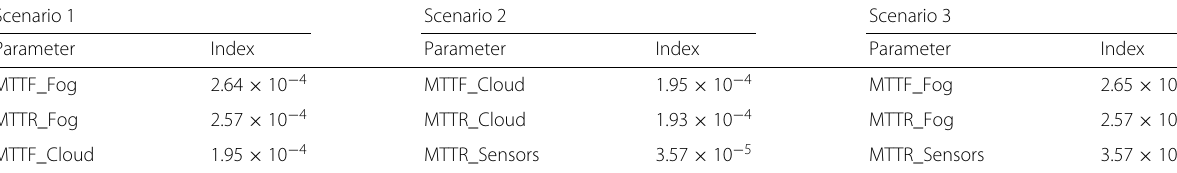
Table 8 Indexes of the three paramaters that affect more the metric of each scenario